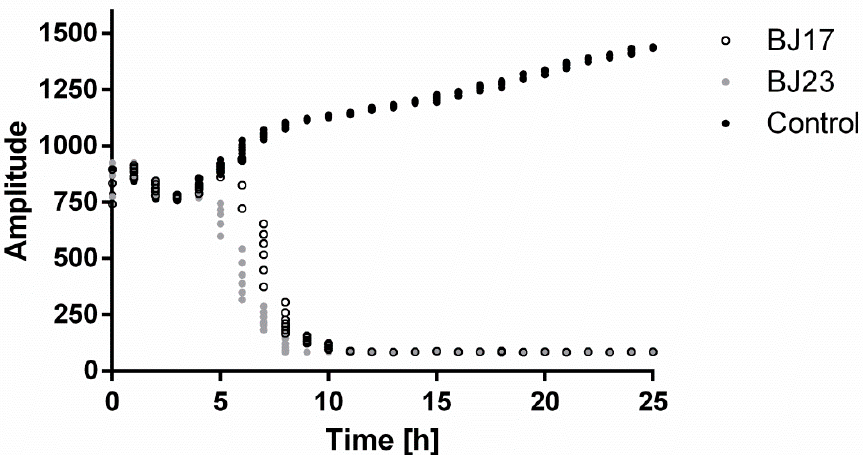
Figure 1. HepG2 PER2-dluc cell line activity measured with Lumicycle. Co-cultures with bacterial strain BJ17 (white dots) or BJ23 (grey dots) and control HepG2 PER2 - dluc cells without bacteria (black dots). Data are represented as the mean of two separate experiments.